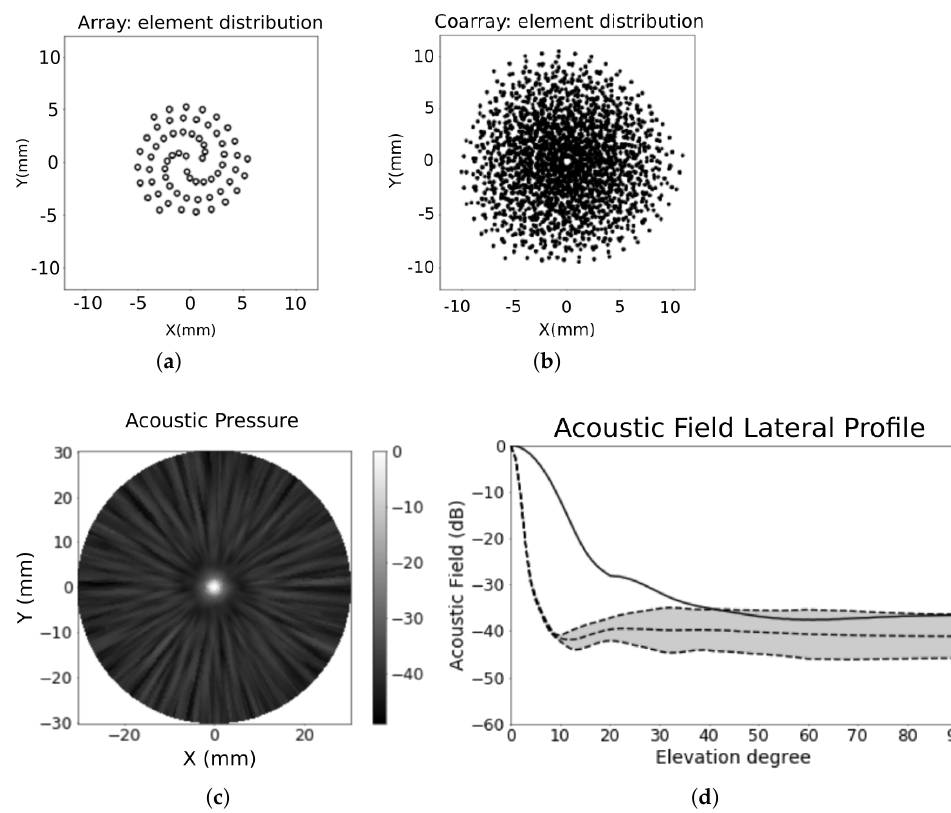
Figure 5. The 64-elements Fermat spiral array. ( a ) Array footprint; ( b ) coarray footprint; ( c ) acoustic pressure in the semi-sphere [ θ = 0 ◦ :90 ◦ , φ = 0 ◦ :360 ◦ ] and ( d ) lateral profile showing the distribution of the sidelobes in elevation. The dashed lines represent the spiral beampattern, and the light grey area within that lines shows sidelobe distribution at each elevation angle. The solid line is the corresponding beampattern of a 64-elements matrix array (8 × 8